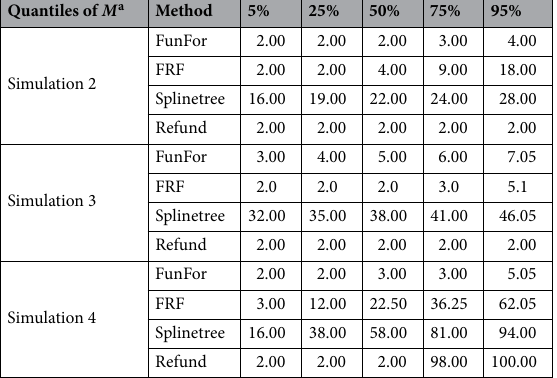
Table 3. The quantiles of the minimum selection sizes of the four approaches for the Simulation Examples a 2–4. M stands for the minimum selection size that is required to include all of the true predictors in each replication. The closer of different quantiles, the